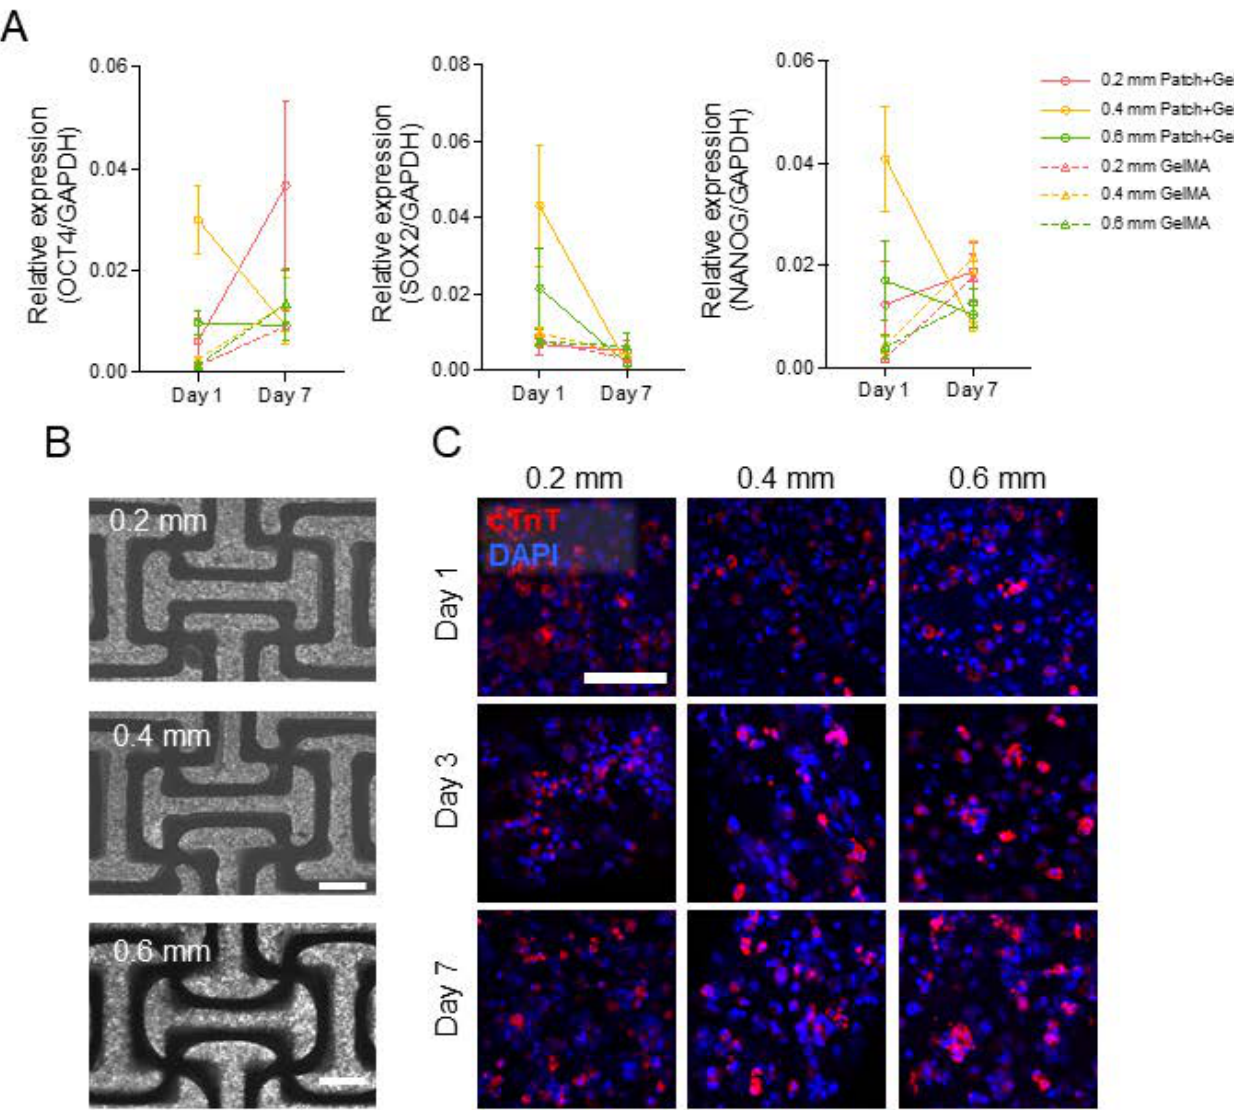
Figure 4. ( A ) Expression of pluripotent genes (Oct4, Nanog, and Sox2) from iPSC-CMs embedded in auxetic patches and GelMA alone patches, collected at day 1 and day 7. Mean ± SD. ( B ) Representative bright-field images of CM distribution in auxetic patches at day 7. Scale bar = 500 µ m. ( C ) The auxetic patch embedded iPSC-CMs were stained against cardiac troponin T (red) and nucleus (blue) at day 1, 3, and 7. Scale bar = 100 µ